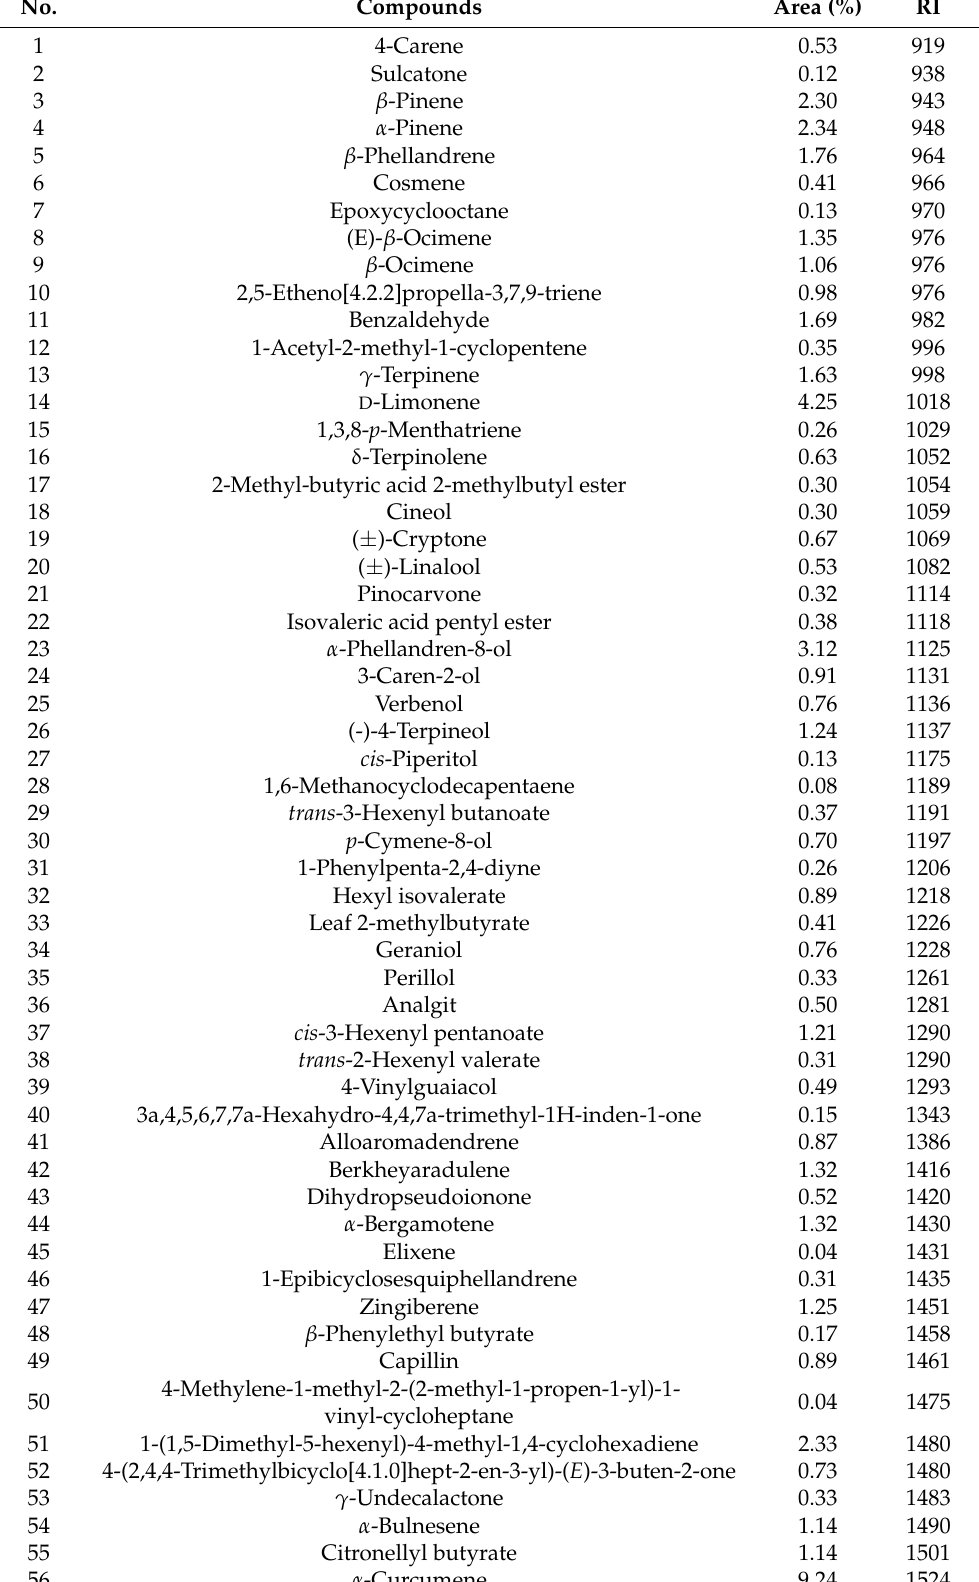
Table 1. Chemical composition of the essential oil extracted from the aerial parts of Artemisia ordosica through